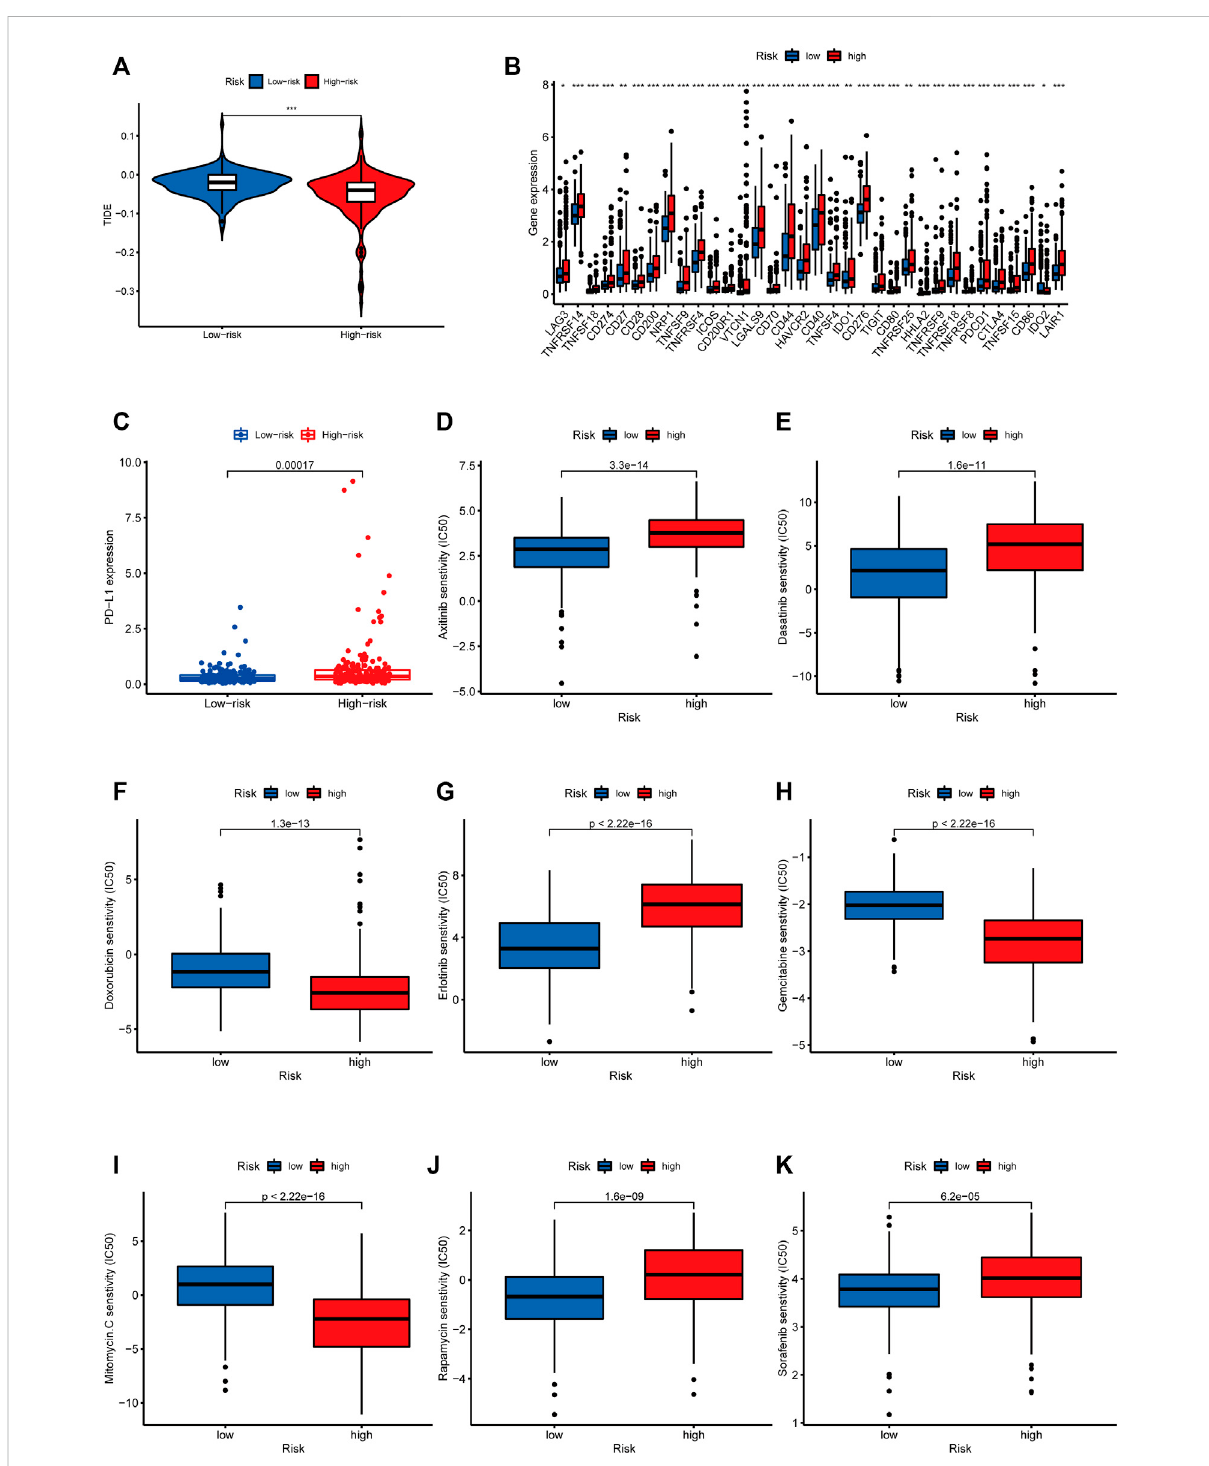
FIGURE 10 Analysis of immunotherapy and chemotherapy responses based on m5C-related lncRNAs risk model. (A) Comparison of TIDE scores between the high-risk and low-risk groups. (B) The difference of 34 immune checkpoints expression level between high- and low-risk groups shown in the box plot. (C) Differences in PD-L1 expression between high- and low-risk groups. IC 50 of axitinib (D) , dasatinib (E) , doxorubicin (F) , erlotinib (G) , gemcitabine (H) , mitomycin.C (I) , rapamycin (J) , and sorafenib (K) in high- and low-risk